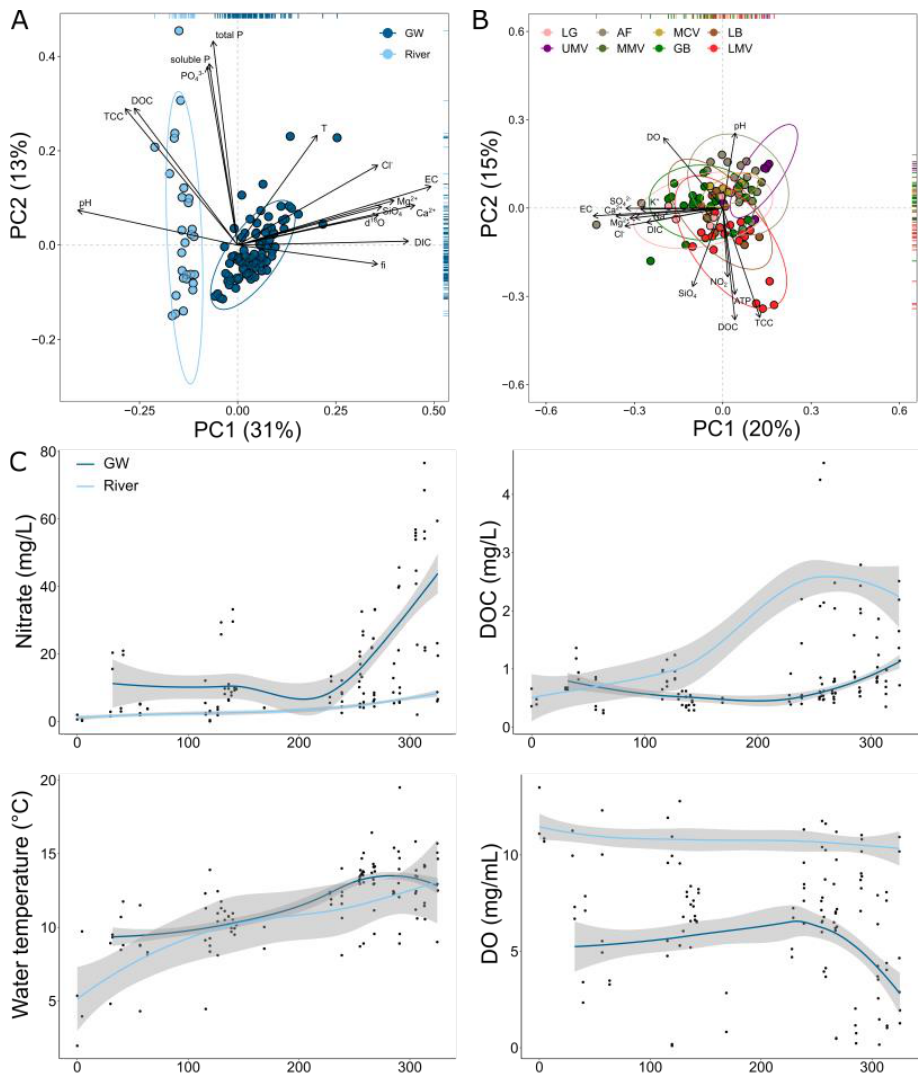
Figure 2. ( A ) Principal component analysis (PCA) based on selected environmental parameters clearly separates groundwater and river water samples. ( B ) Groundwater samples colored according to their origin in terms of sub-regions (groundwater bodies). The ellipses depict the 95% confidence interval ellipses ( A , B ). ( C ) Nitrate, DOC, and DO concentrations, as well as water temperature (each sampling site represented by a summer and autumn value), are plotted against the distance to the Mur River source. Grey shading indicates the 95% confidence intervals. (TCC: total cell count; ATP: cellular adenosine triphosphate; DOC: dissolved organic carbon; T: water temperature; DO: dissolved oxy gen; EC: electrical conductivity; δ 18 O: stable 1 8 O isotope signature in water; NO 2 : nitrite; PO 43 − : orthophosphate; Na + : sodium; K + : potassium; Ca 2+ : calcium; Mg 2+ : magnesium; Cl − : chloride; SO 42 − : sulfate; soluble P: soluble phosphorus; total P: total phosphorus; SiO 4 : silicate; DIC: dissolved inorganic carbon.) Table 1. Key physicochemical features of groundwater (GW) and river water samples collected in the River Mur Valley in summer and autumn 2020. Data are means ± SD.